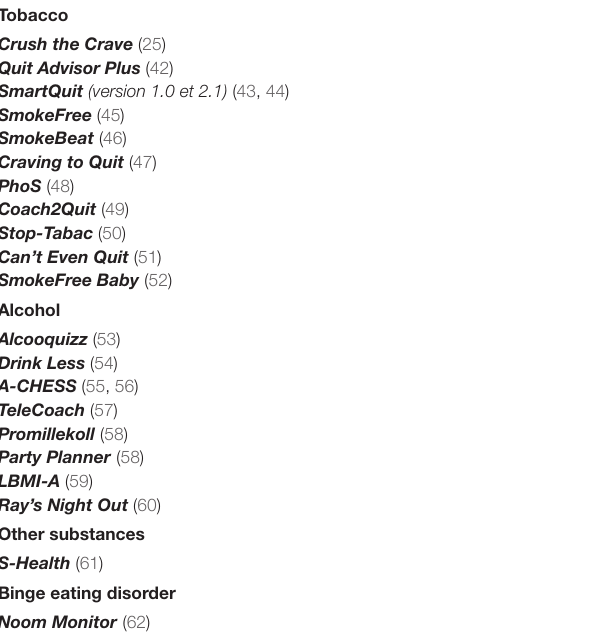
TABLE 2 | List of applications identified by the systematic review. Tobacco Crush the Crave (25) Quit Advisor Plus